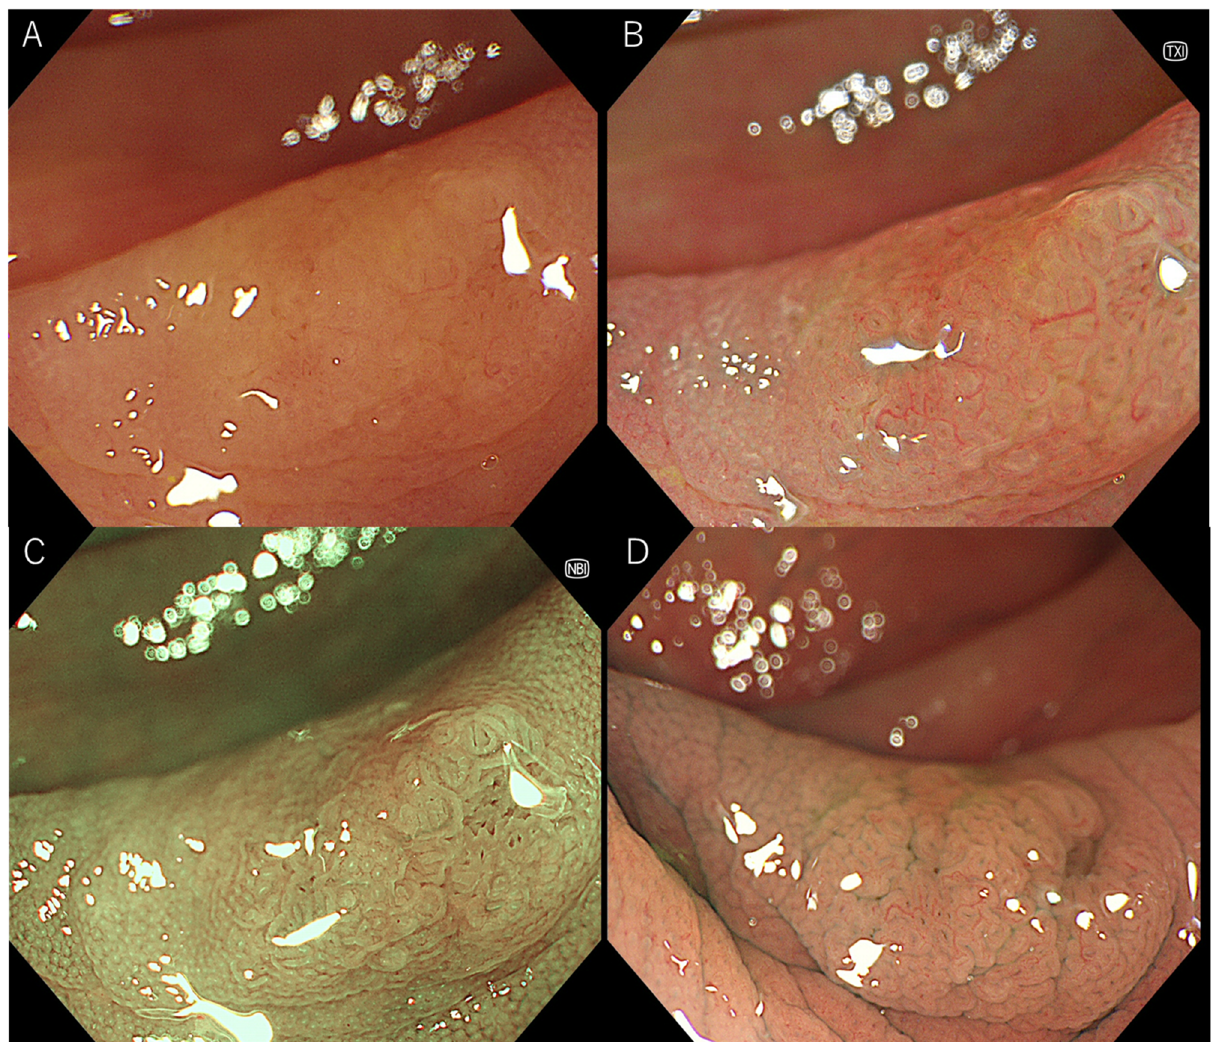
Figure 2. Representative images of sessile serrated lesion with magnification. ( A ) white-light imaging, ( B ) texture and color enhancement imaging, ( C ) narrow-band imaging, ( D ) chromoendoscopy.